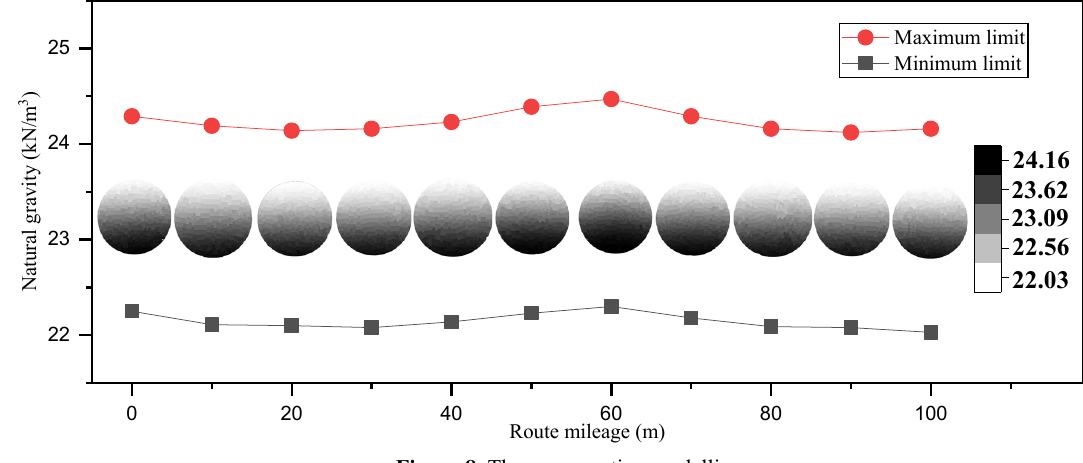
Figure 8 . The cross-section